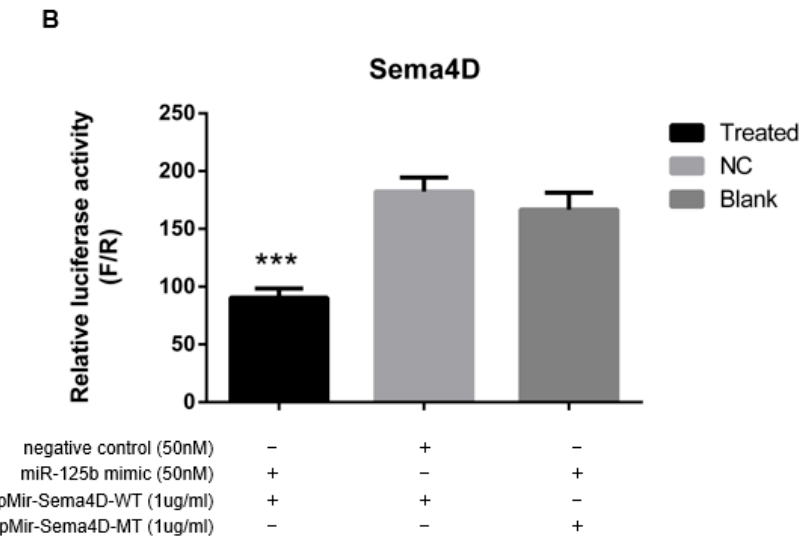
Figure 2. miR-125b binds the Sema4D 3 ′ UTR. ( A ) TargetScan predicted the seed regions of the Sema4D 3’-UTR that bind miR-125b. ( B ) Luciferase assays were performed after co-transfecting reporter plasmids with a miR-125b mimic or inhibitor as follows: Treated, miR-125b mimic (50 nM) co-transfected with the pMir-Sema4D-WT (containing the wild type seed sequence) luciferase reporter; NC, miR-125b inhibitor co-transfected with the pMir-Sema4D-WT luciferase reporter; Blank, miR-125b mimic co-transfected with pMir-Sema4D-MT (containing the mutated seed sequence). Luciferase activities were tested 48 h post-transfection. The data are provided as means ± standard deviation for three replicates from a representative experiment. *** P < 0.001.